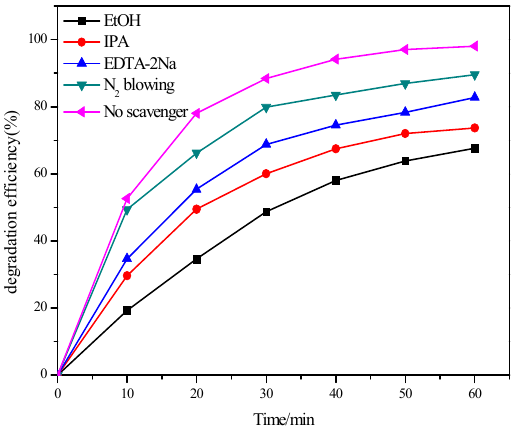
Figure 9. E ff ect of di ff erent reactive radical species on the degradation e ffi ciency of NOR with 10 mg / L Figure 9. Effect of different reactive radical species on the degradation efficiency of NOR with 10 mg/L initial concentration in PFC / PS system. Experimental conditions: [EtOH] = [IPA] = 0.3 M, [EDTA-2Na] initial concentration in PFC/PS system. Experimental conditions: [EtOH] = [IPA] = 0.3 M, [EDTA- = 4mM, [PS] = 3 mM, pH = 3, and electrolyte: 0.1 M Na 2 SO 4 2Na]=4mM, [PS]=3 mM, pH=3, and electrolyte: 0.1 M Na 2 SO 4 .